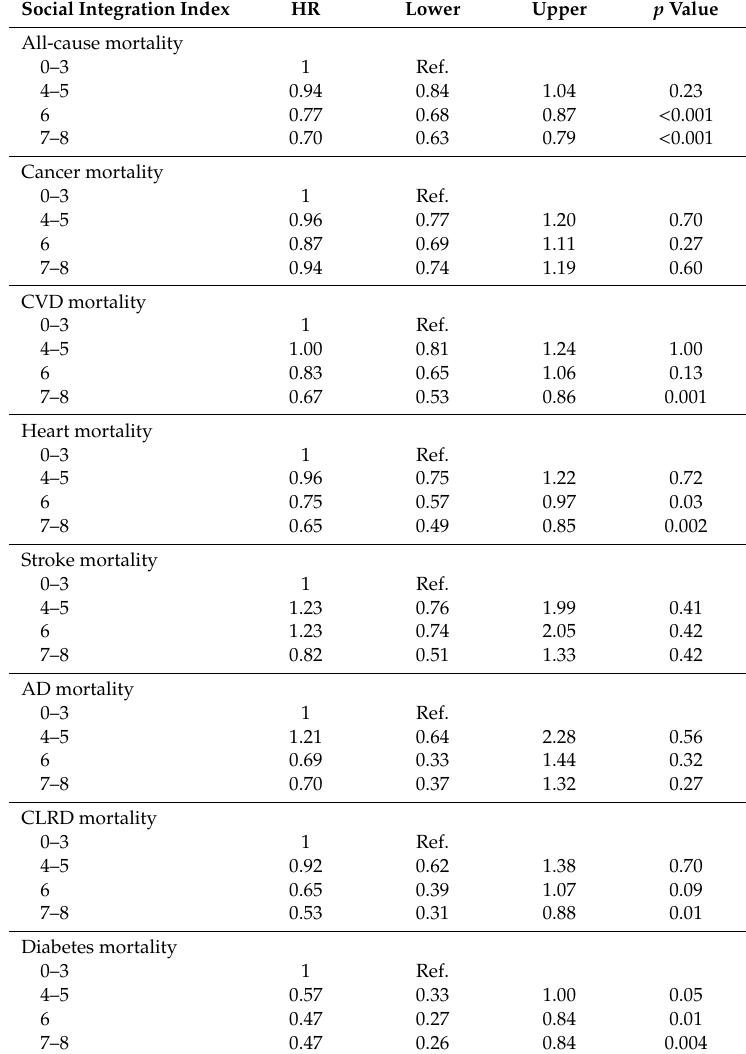
Table 2. Hazard ratios for all-cause, cardiovascular, and cause-specific mortality by received social integration